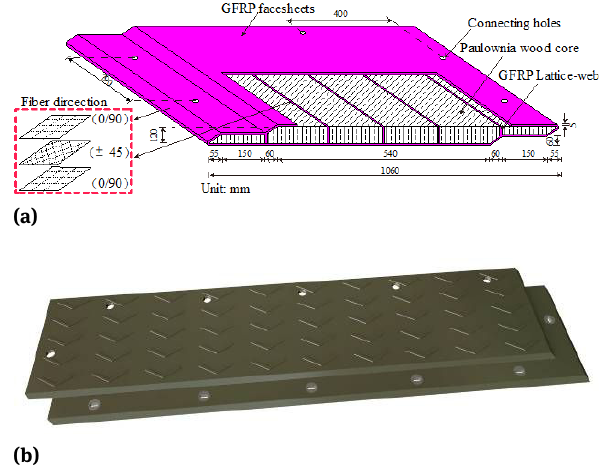
Figure 1: Specific geometry dimensions of composite sandwich matting with total thickness of 120 mm. (a) geometry dimensions of the section view, (b) sketch map of the composite sandwich